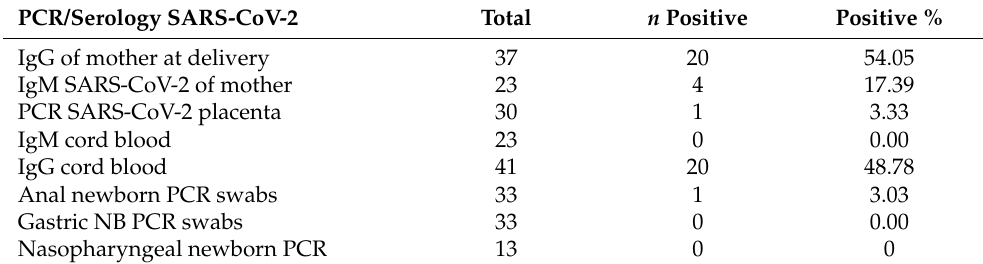
Table 5. SARS-CoV-2 findings at delivery in the placenta, cord blood, and newborns of mothers with